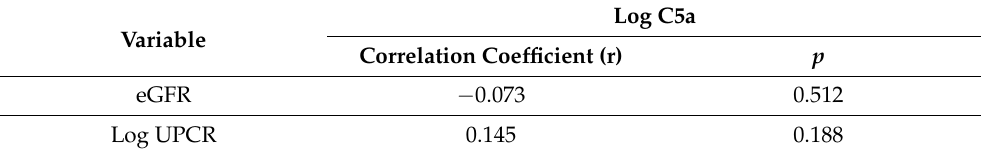
The correlation analysis was performed using Pearson’s correlation test after logarithmic transformation of the levels of factor Ba, UPCR and C5a. *, p < 0.05, indicates a significant correlation between the two variables. eGFR, estimated glomerular filtration rate; UPCR, urine protein to creatinine ratio. Table A3. Correlation analysis of the plasma factor C5a level with clinical